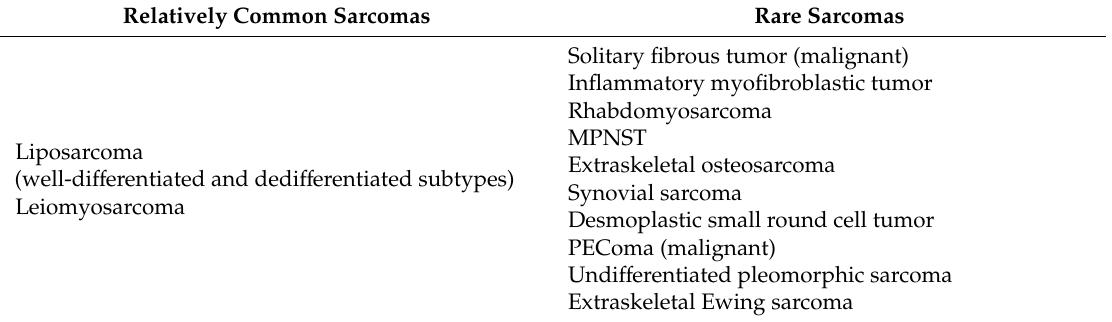
Table 1. Relatively common and rare sarcomas arising in the